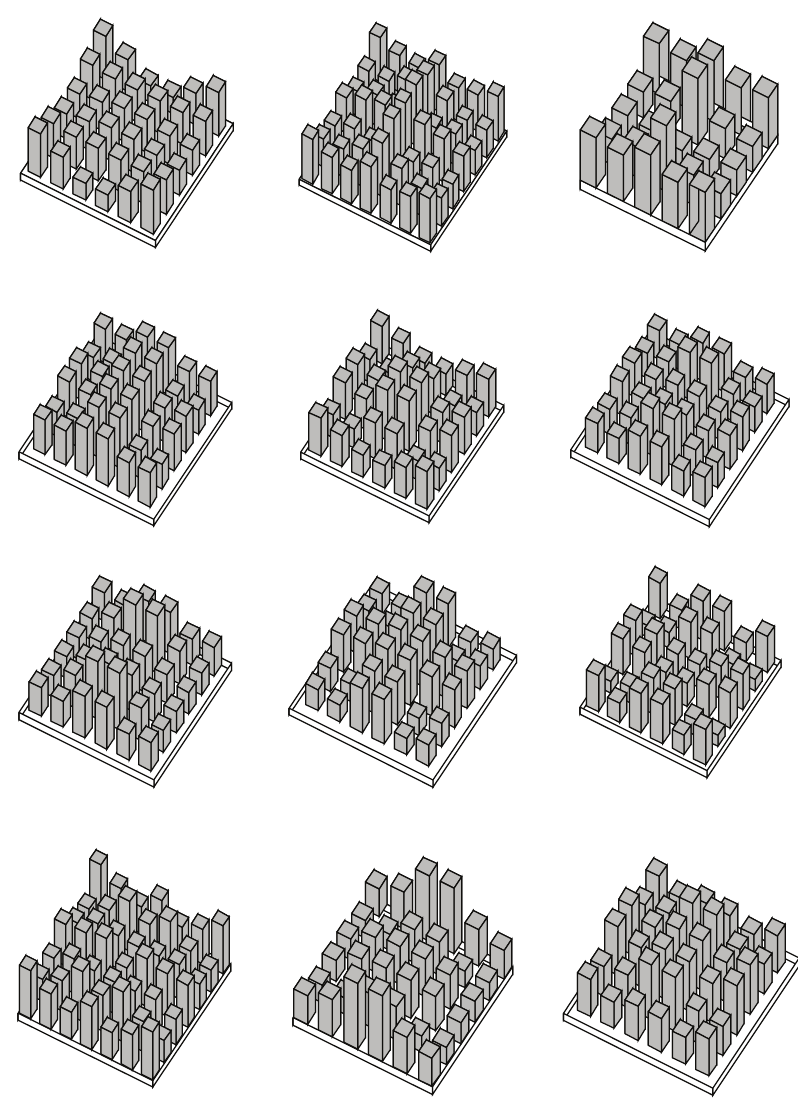
Figure 8: Selected PFHSs from the front of